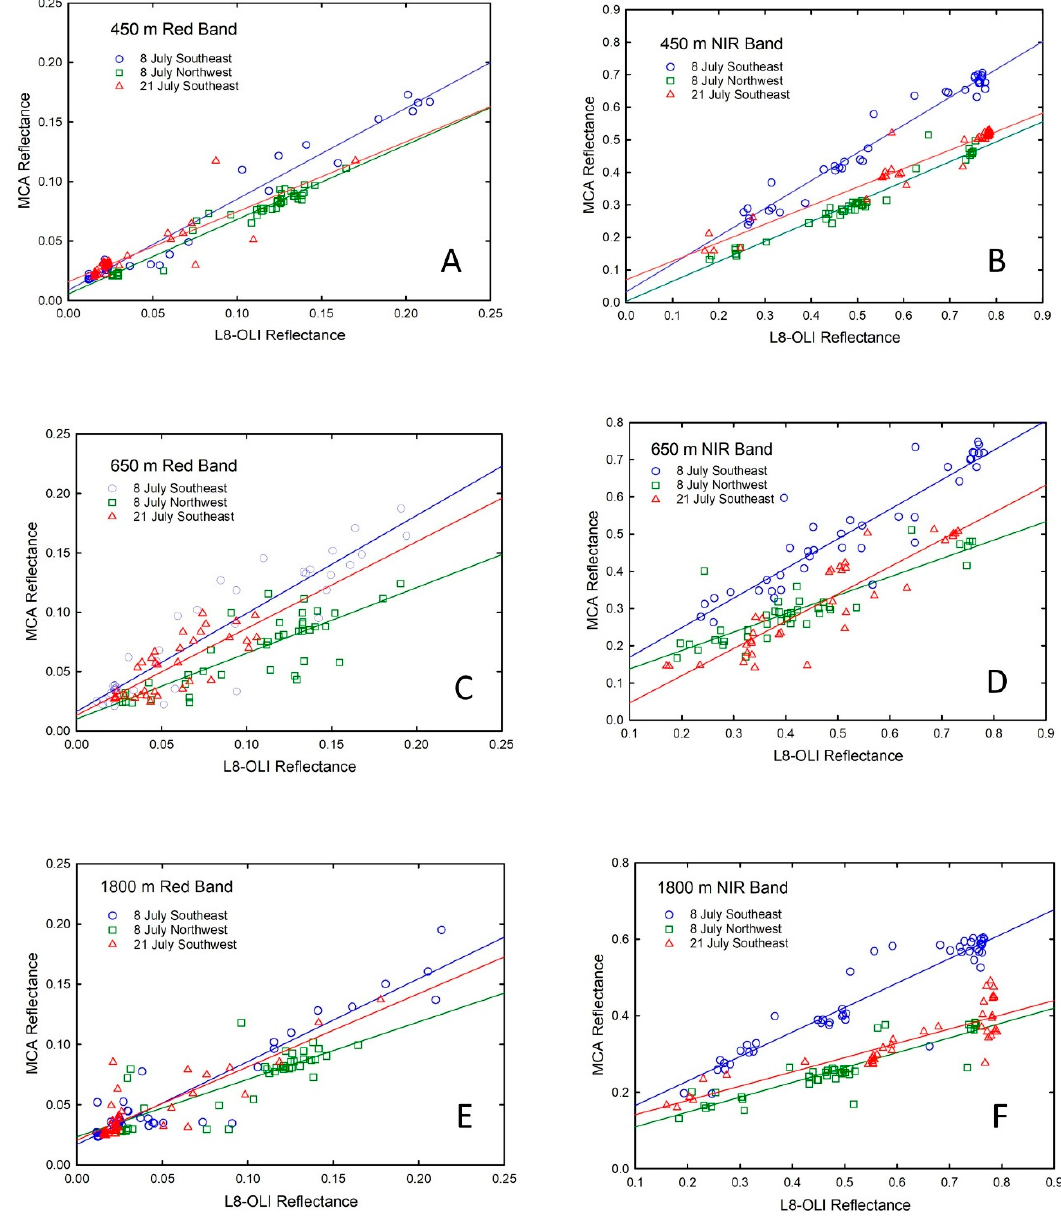
Figure 4. Comparison of Mini-MCA and Landsat 8 OLI reflectances acquired from southeast and Figure 4. northwest flight directions at three altitudes AGL on 8 July and 21 July 2014: ( A ) red reflectance at 450 m, ( B ) NIR reflectance at 450 m, ( C ) red reflectance at 650 m, ( D ) NIR reflectance at 650 m, ( E ) red reflectance at 1800 m, and ( F ) NIR reflectance at 1800